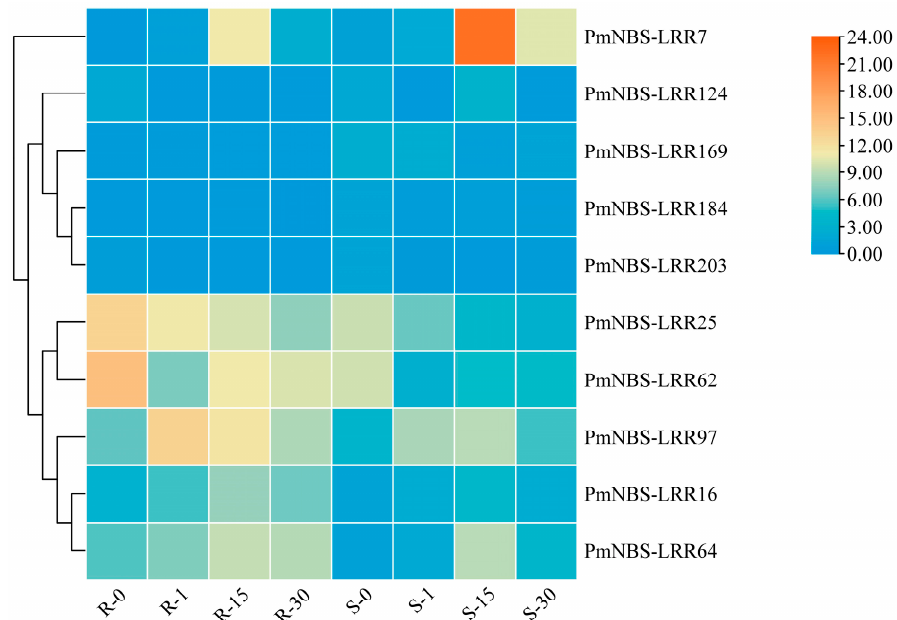
Figure 2. Expression patterns of differential NBS-LRR genes in different periods of resistant and susceptible P. massoniana inoculated with the PWN. High expression levels and low expression levels were represented by orange and blue, respectively. Differential genes were hierarchically clustered according to their expression and divided into different gene clusters in the graph.